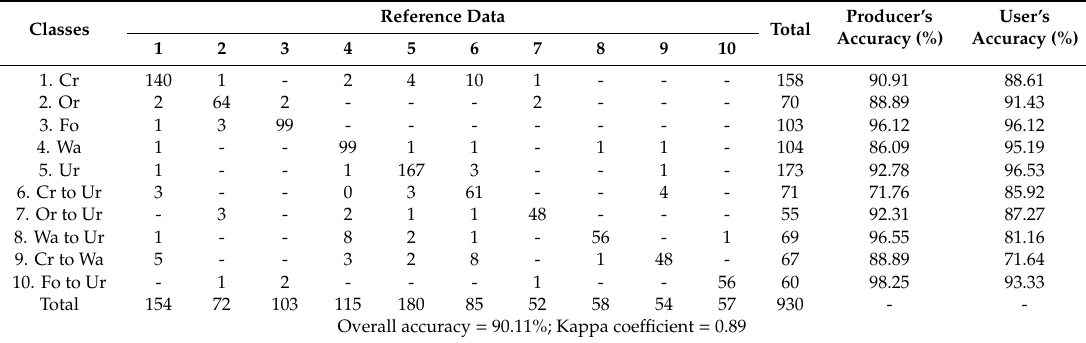
Table 6. Confusion matrix of the post-classification method, 2003–2006.